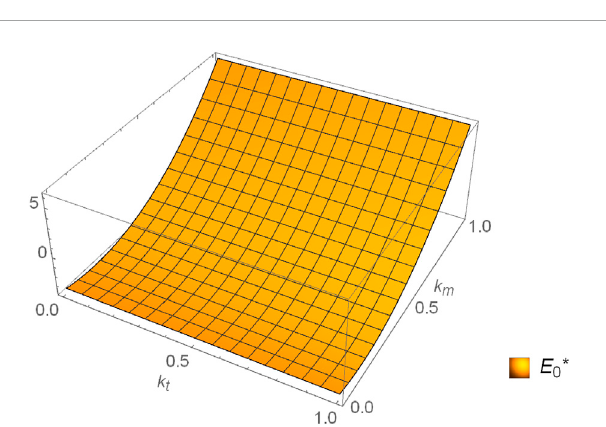
FIGURE 5 The impact of δ on equilibrium solutions.